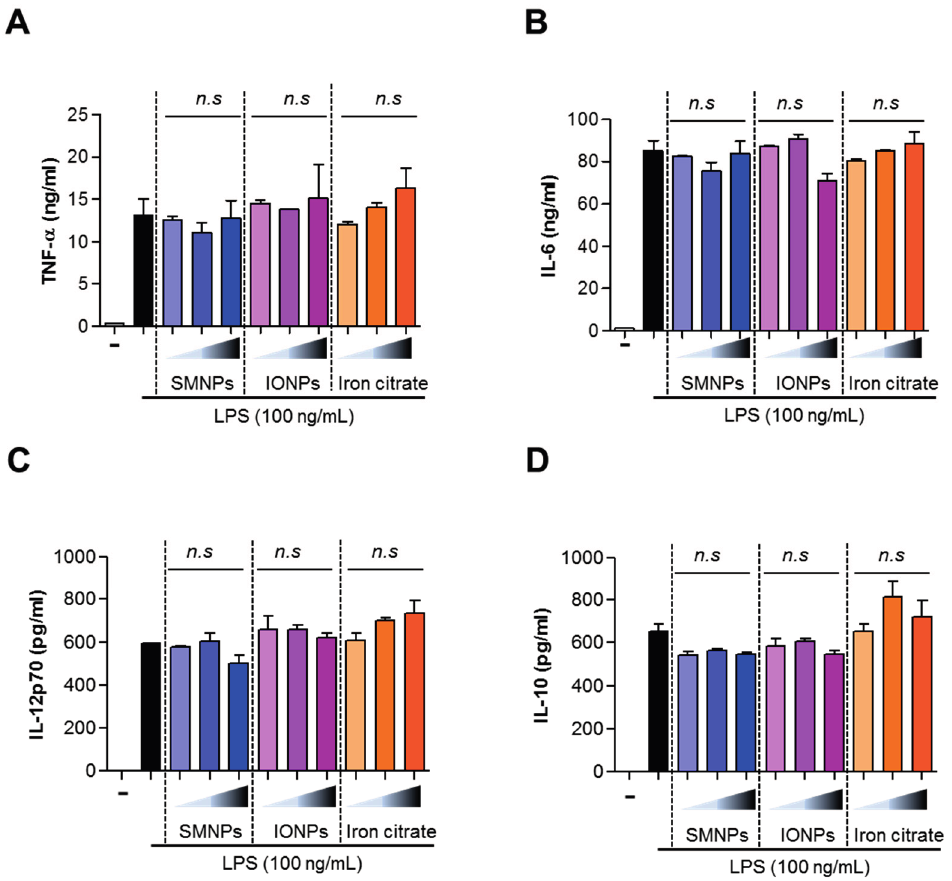
Figure 7. Effects of surface-modified nanoparticles (SMNPs), iron oxide